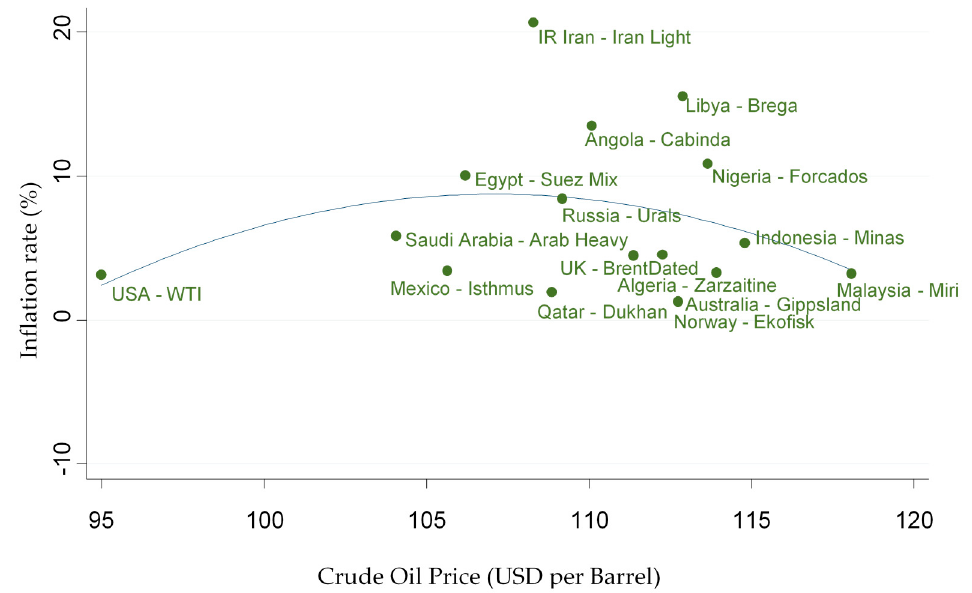
Figure 2. The crude oil price and inflation rates in oil-exporting countries. Notes: The curve was the best-fit curve to the scatter plot. The shaded area displays the 95% confidence intervals. The oil-exporting countries included in the graph and their respective oil prices are the United States (WTI), IR Iran (Iran Light), Libya (Brega), Angola (Cabinda), Egypt (Suez Mix), Nigeria (Forcados), Russia (Urais), Saudi (Arab Light), Dubai (Arab Heavy), Indonesia (Minas), Mexico (Isthmus), United Kingdom (Brent), Angola (Girassol), Malaysia (Miri), Australia (Gipp), Qatar (Dukhan), and Norway (Ekofisk). Source: This graph was plotted by the first author based on the data reported in the OPEC Annual Statistical Report [8] using the Stata Statistical Software Release 13 (StataCorp LP, TX, USA).